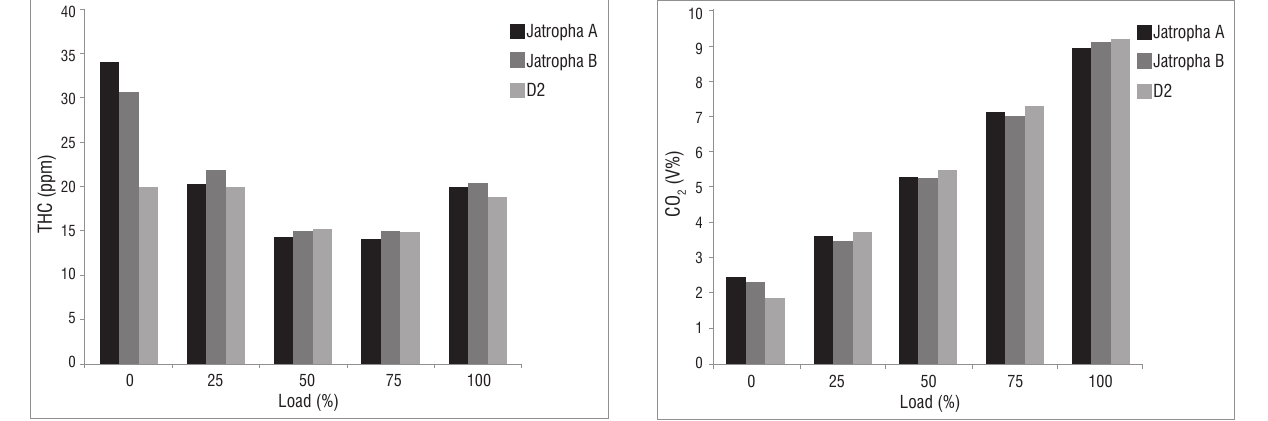
) emissions for the different fuel samples Figure 5: Carbon dioxide (CO 2 at different loads. Smoke Smoke emissions with increasing load are shown in Figure 6. Diesel fuel exhibited the highest smoke emissions at all loads, whilst Jatropha B exhibited the lowest emissions under the same load conditions. Maximum smoke emission values were observed at 100% load for all fuels. The presence of oxygen in Jatropha A and B samples could explain their lower emission values. 13,24